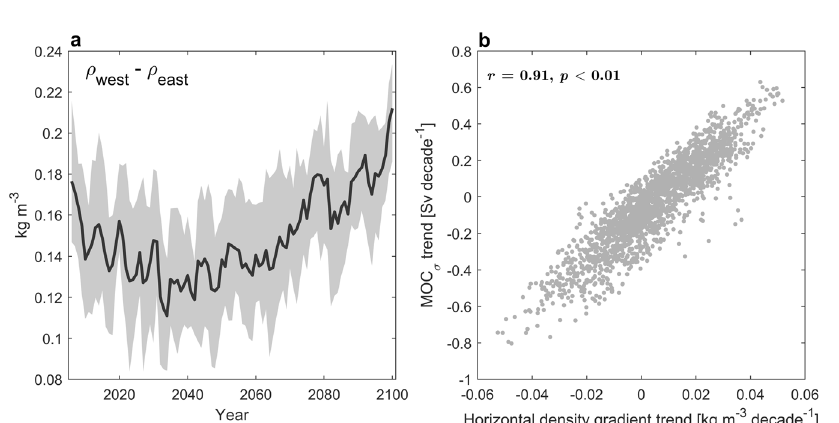
Fig. 6 | Horizontal density gradient. a West-east density gradient across 70°N between200 – 500minCESM-LE.Thegradientiscalculated between10 – 20°Wand 7 – 17°E. Solid line shows the ensemble mean and the shading indicates the